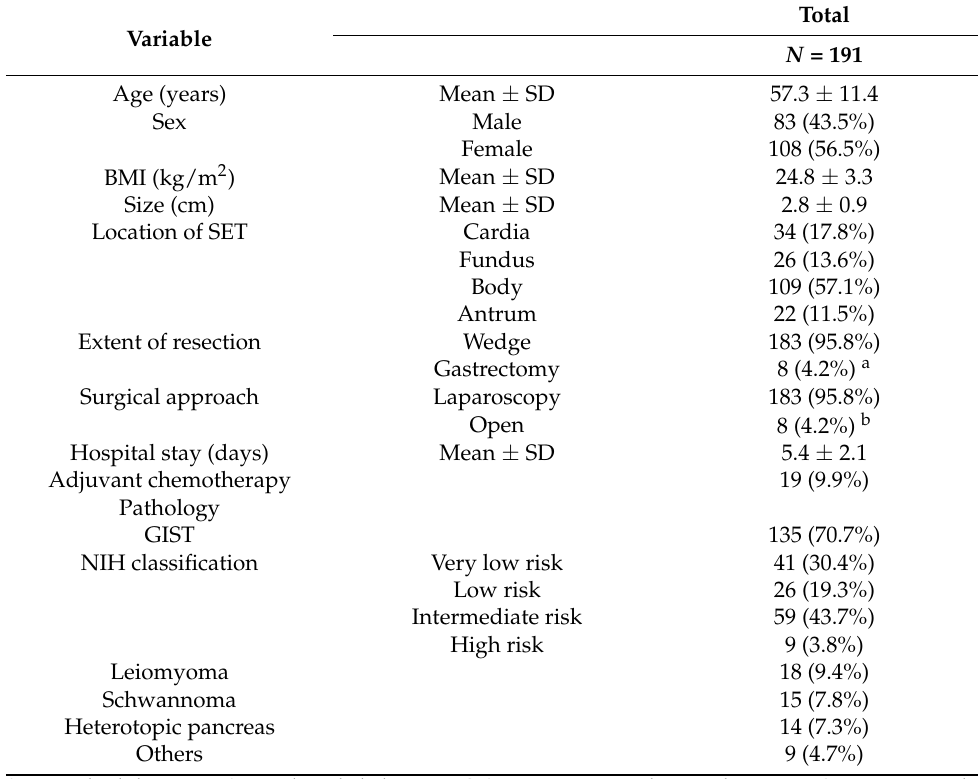
Table 1. Baseline characteristics of